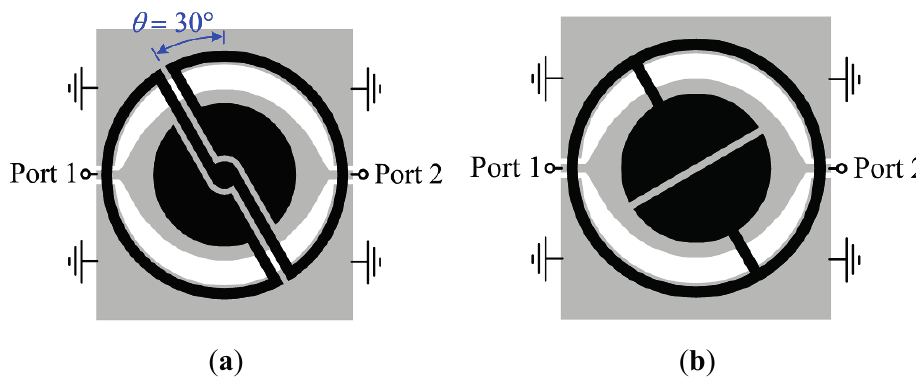
Figure 11. ( a ) Topology of the proposed rotation sensor based on an S-SRR; ( b ) Equivalent macroscopic topology for a sensor based on an ELC for comparison purposes. The CPW dimensions and substrate are the same as those in Figure 6. Resonator dimensions are: external loop mean radius r 0 = 8.175 mm, circular patch outer radius r 1 = 5 mm, s = 0.5 mm, and c = 0.75